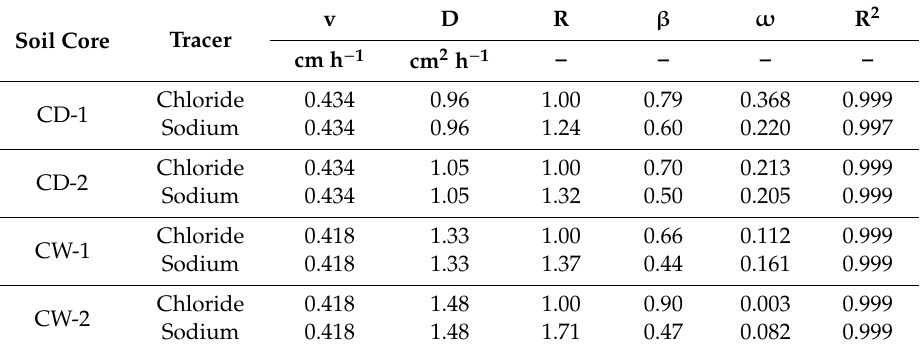
Figure 3. ( a ) Chloride (Cl ) and ( b ) sodium (Na + ) breakthrough curves plotted as relative concentrations (C / Co) against the number of pore volumes. The lines represent the fitted breakthrough curves using the mobile and immobile model. Table 2. Values of optimized parameters from MIM (average pore water velocity, v; dispersion coefficient, D; retardation factor, R; mobile water fraction, β ; mass transfer coefficient, ω ) and coefficient of determination, R 2 .